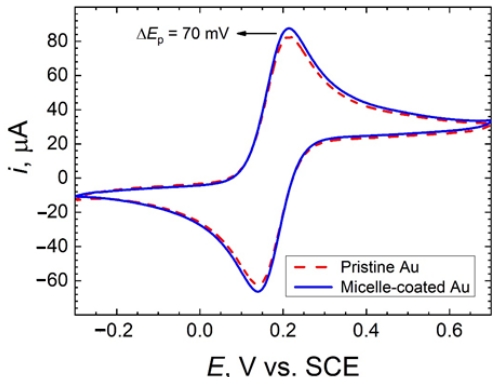
Figure 2. Cyclic voltammogram for pristine and micelle-coated gold electrodes in 0.1 M KCl + 1 mM ferrocenemethanol. Scan rate: 20 mV s − 1 ; Area: 0.5 cm 2 .